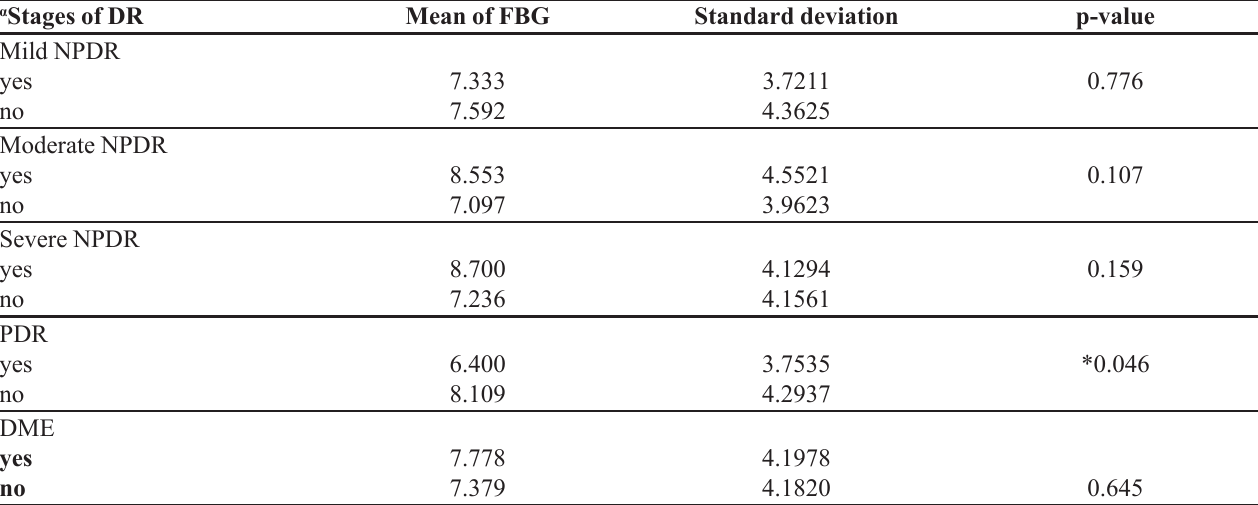
TABLE IV - Association of FBG with severity of diabetic retinopathy (DR) and diabetic macular edema (DME) (N=104) α Stages of DR Mean of